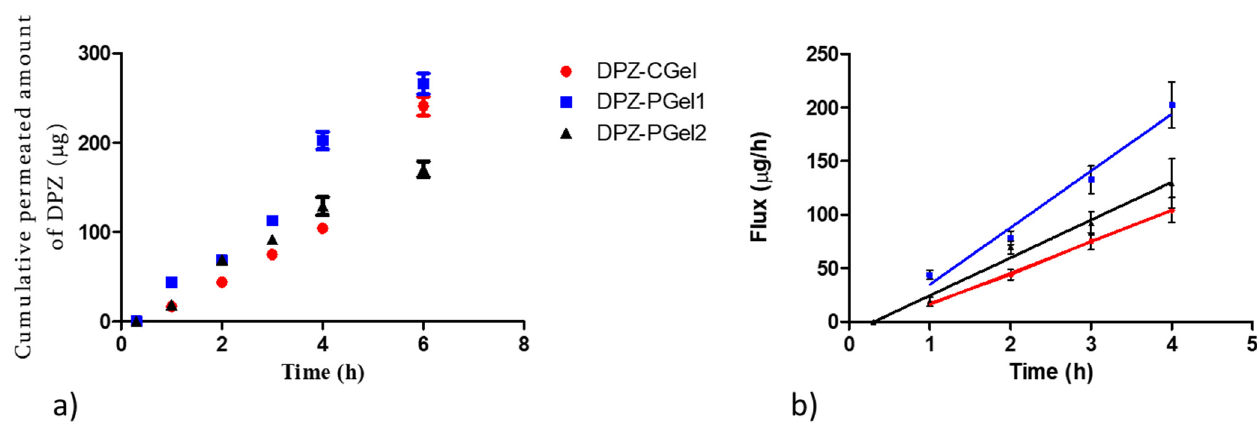
Gels 2022 , 8 , 715 Figure 7. Profiles of donepezil released from the formulations, assessed by in vitro drug release tests.